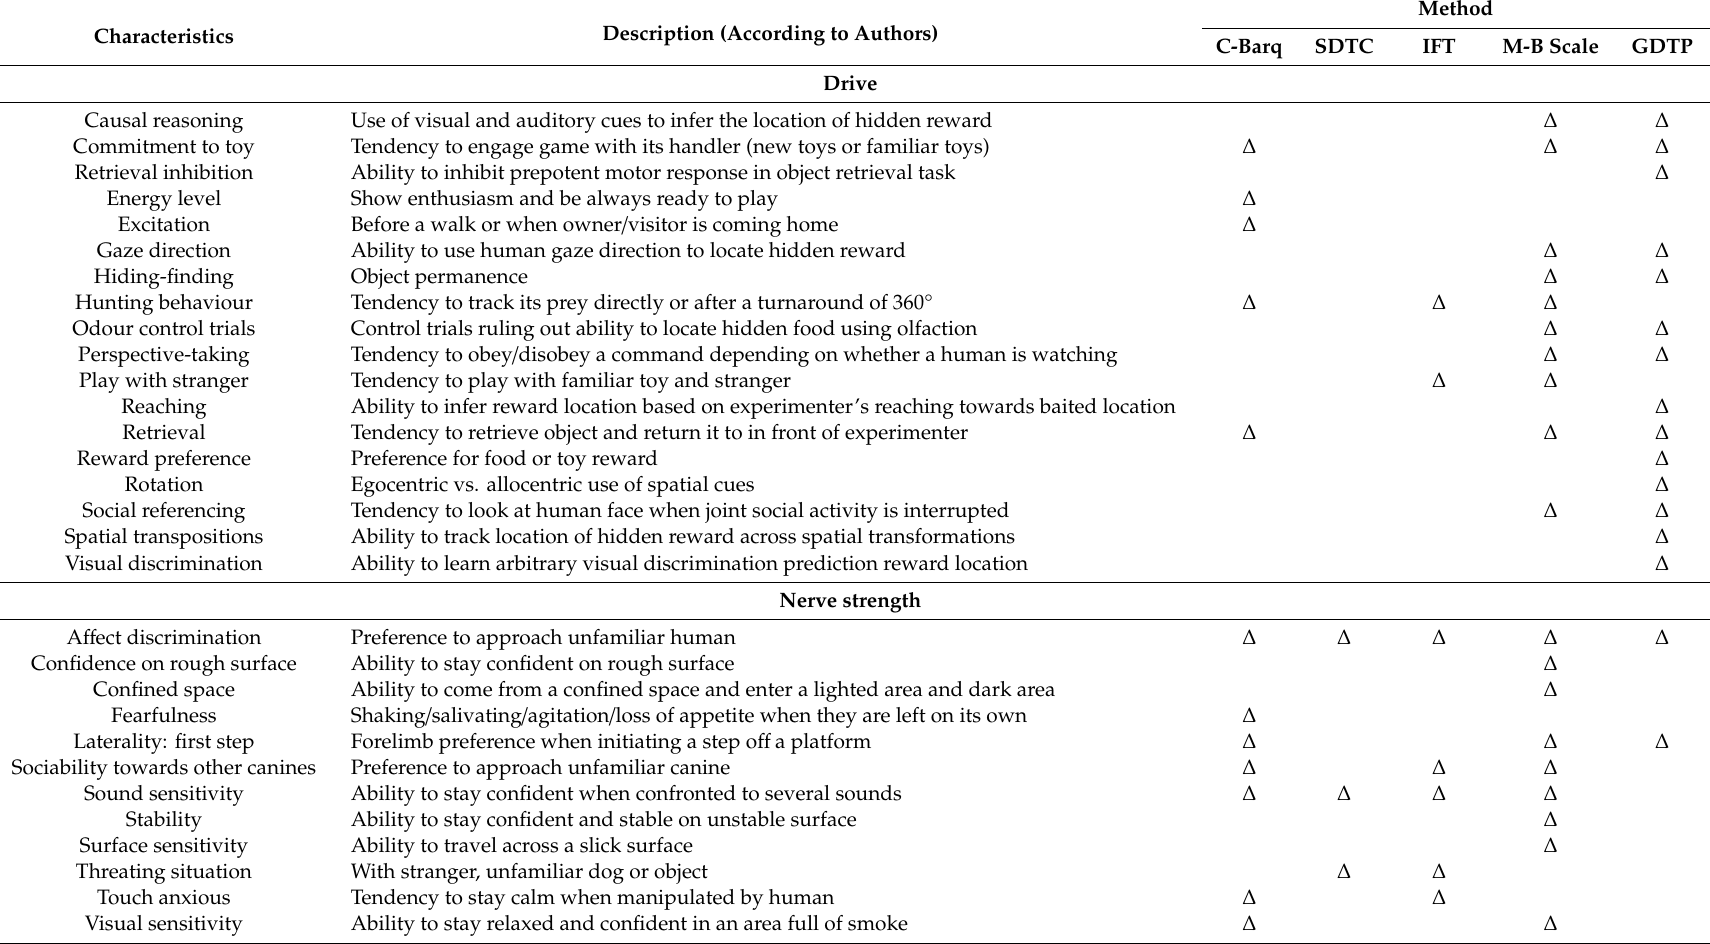
Table 3. Selection methods of detection and service